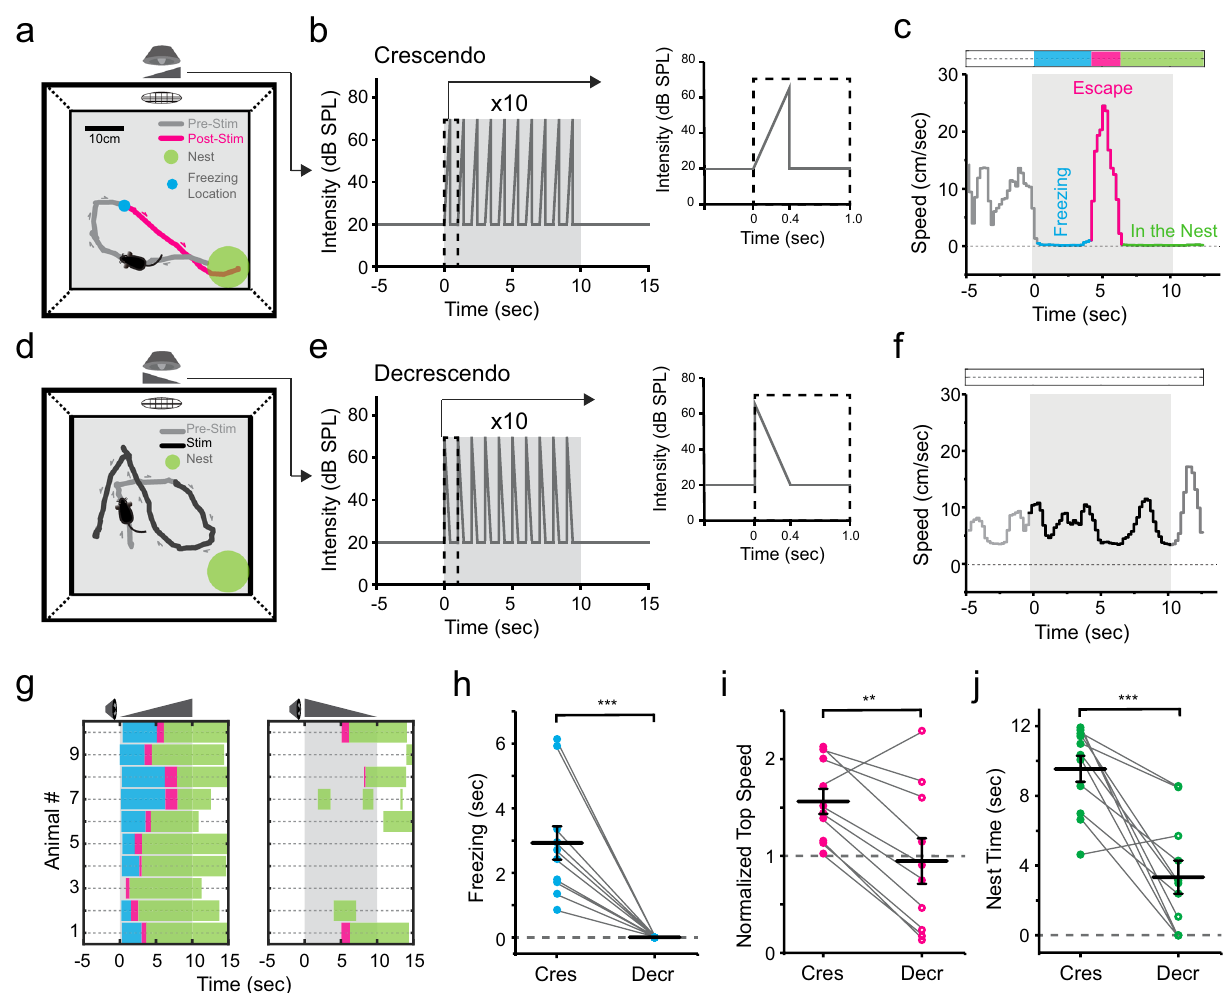
Fig. 1 Looming sound-induced freezing-escape defensive behavior. a Schematic diagram of open fi eld test for sound-induced behavior. A speaker was attached to one of the walls. A nest (green circle) was placed in a corner. Gray and red traces label the movement trajectory before and after presenting (including during) crescendo stimuli respectively for an example animal. Blue dot marks the location of crescendo-triggered freezing. b Illustration of one trial of crescendo stimuli. Right: individual stimulus. c Locomotion speed for the example animal shown in ( a ). Different behavioral phases are labeled by different colors: freezing (blue), escape (red) and nest time (green). d Movement trajectory of an example animal in response to decrescendo stimuli. Gray: before decrescendo stimuli. Black: during presentation of decrescendo stimuli. e Illustration of decrescendo stimuli. f Locomotion speed for the animal shown in ( d ). g , Color-coded behavioral outcome in response to crescendo (left) and decrescendo (right) stimuli in 10 mice. h Comparison of crescendo and decrescendo induced freezing duration. Data points for the same animal are connected with a line. *** p = 1.033 × 10 − 4 , two-sided paired t test, t = 5.669, n = 10 mice. i Comparison of normalized top speed. ** p = 0.003, two-sided paired t test, t = 4.059, n = 10. j Comparison of nest time. *** p = 6.103 × 10 − 5 , two-sided paired t test, t = 5.126, n = 10. Data are presented as mean ± s.e.m. for ( h – j ). The center presents the mean value and the bar represents duration (Fig. 1h, Decr), normalized top speed (Fig. 1i) and nest